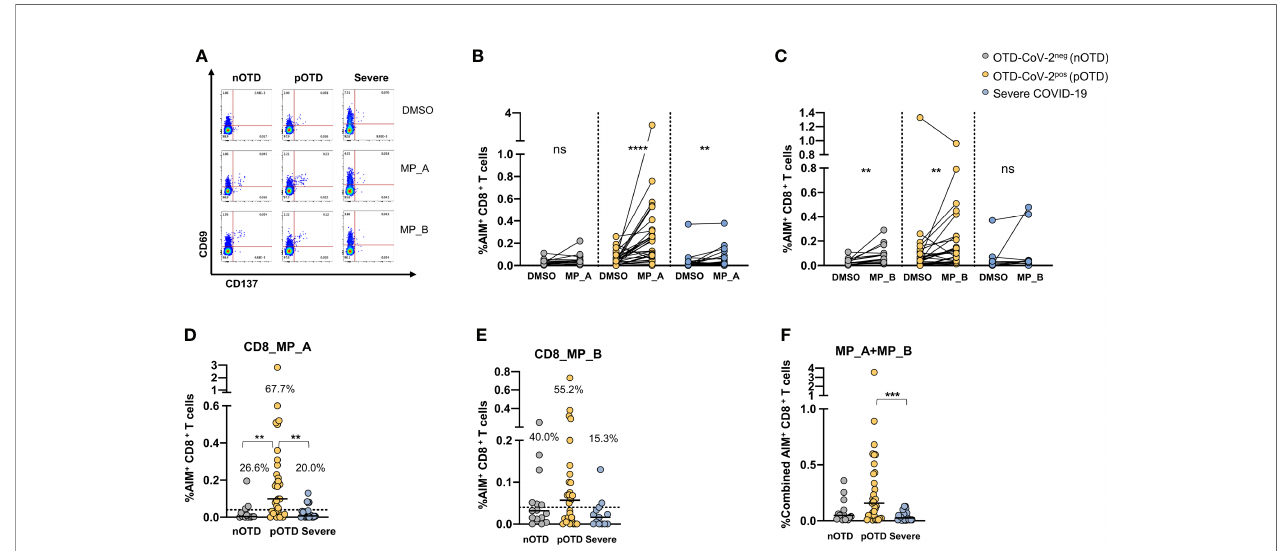
FIGURE 2 | Increased SARS-CoV-2 speci fi c CD8 T cell responses in SARS-CoV-2-infected subjects with OTD. To evaluate SARS-CoV-2-Speci fi c CD8 + T cell responses, PBMC collected from 3 cohorts of subjects were stimulated for 24h with two peptide megapools: MP_A and MP_B. In all experiments, DMSO was used as negative control. (A) FACS plot examples of CD69 and CD137 co-expression on total CD8 + T cells. (B) Frequency of AIM+ (CD69 + CD137 + ) CD8 + T cells measured after PBMC stimulation with MP_A, (C) MP_B megapool, or DMSO negative control is shown for the 3 different groups. (D) Activation of SARS-CoV-2 speci fi c CD8+ T cells, in the presence of MP_A and (E) MP_B megapools, is shown as percentage AIM+ CD8+ T cells after subtraction of the DMSO background in three cohorts of subjects. Dotted black lines indicate cut-off values for positivity. (F) Combined AIM + CD8 + T cells responses to DMSO-subtracted individual peptide megapools. The non-parametric Wilcoxon matched-pairs signed-rank test was used to compare data within the same group. Statistical comparison between three groups of subjects was done by the non-parametric Kruskal-Wallis test followed by Dunn ’ s multiple comparisons. ns, not signi fi cant. **p < 0.01; ***p < 0.001; ****p <